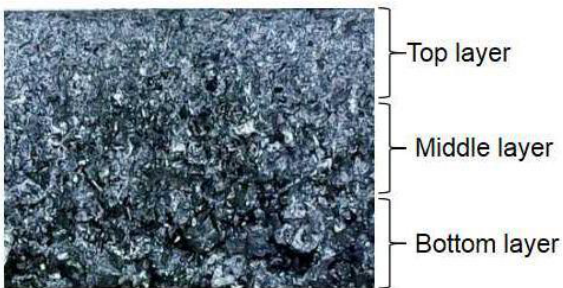
Figure 5. The longitudinal structure of the filter cake.